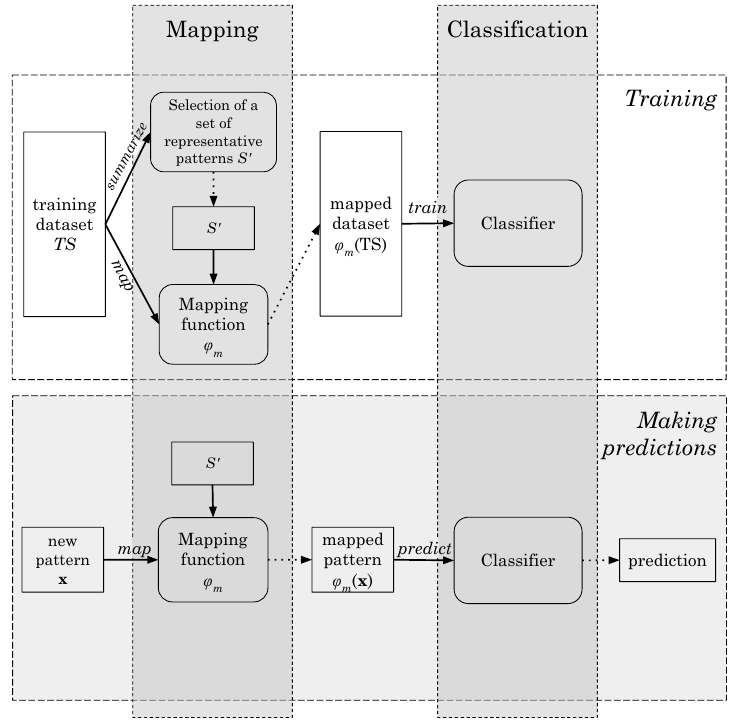
Figure 2. Workflow diagram of the shape-based